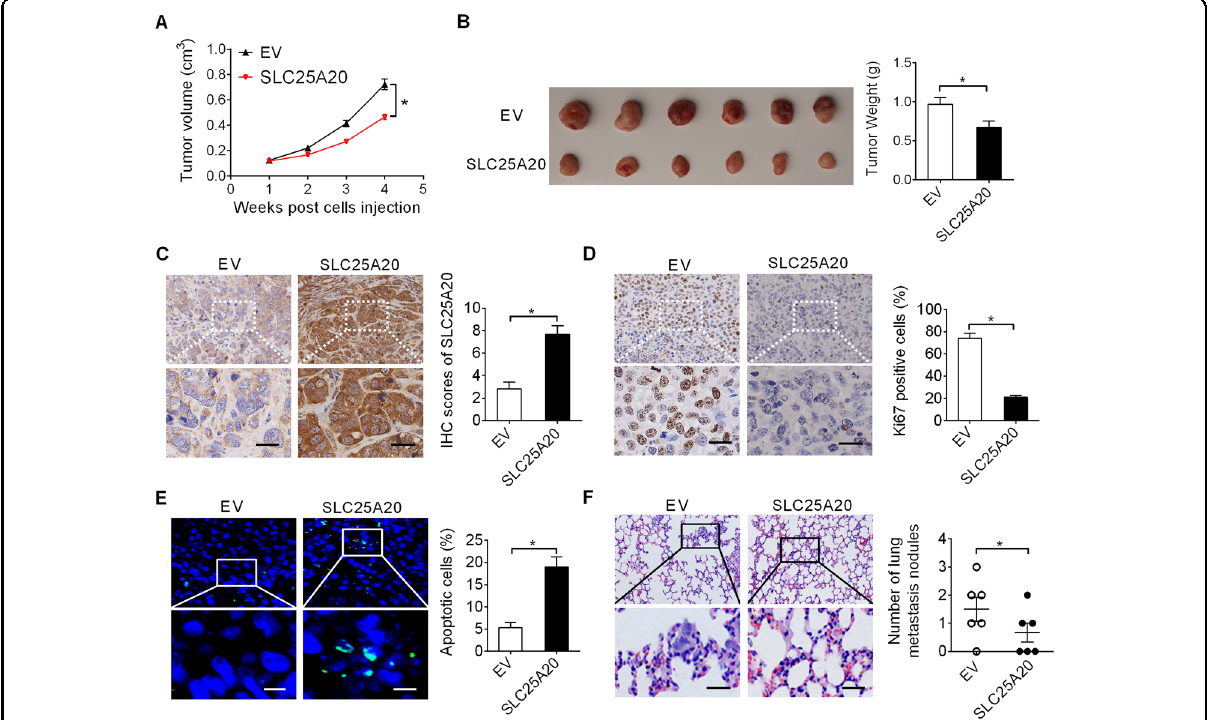
Fig. 4 Forced expression of SLC25A20 suppressed HCC growth and metastasis in vivo. A Tumor-growth curves of xenografts established from HLF cells transfected with SLC25A20 expression vector (SLC25A20) or empty vector (EV). B The weights of tumors dissected from the nude mice at termination of the experiment were compared. C , D The expression levels of SLC25A20 and Ki-67 were determined by IHC staining analysis in xenografts developed from HLF cells transfected with SLC25A20 expression vector or empty vector. Scale bars, 10 μ m. E TUNEL staining in xenografts developed from HLF cells transfected with SLC25A20 expression vector or empty vector. Scale bars, 5 μ m. F Incidences of lung metastases were determined in the two groups with different levels of SLC25A20 expression. Scale bars, 10 μ